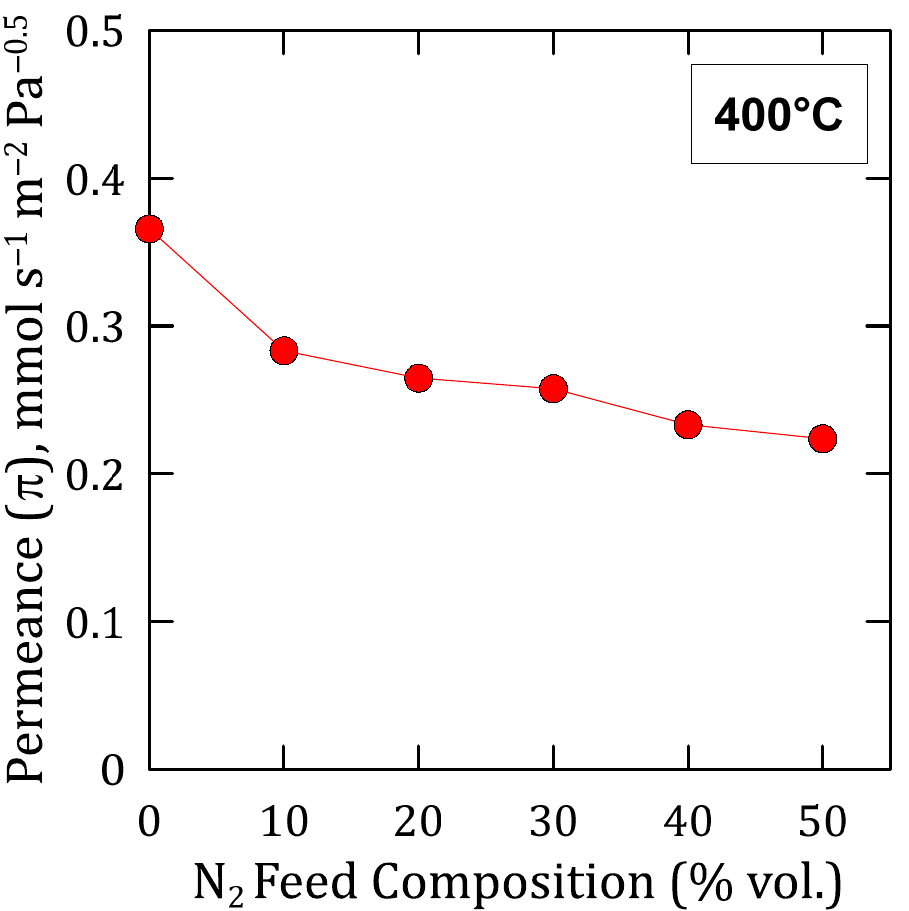
Figure 9. Hydrogen permeance at 400 ◦ C reached for different compositions of H 2 –N 2